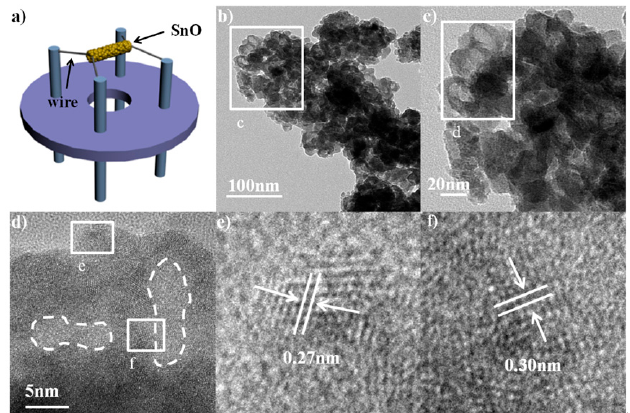
Figure 1. Configuration of the as fabricated devices and morphology of as prepared Sample 3. ( a ) The configuration of sensor devices. ( b , c ) TEM (transmission electron microscopy) image of Sample 3 at different magnifications. ( d ) TEM image of Sample 3 which expands the top-left section of ( b ). ( e , f ) HRTEM (high-resolution transmission electron microscopy) image of corresponding white solid frames marked in ( c ).